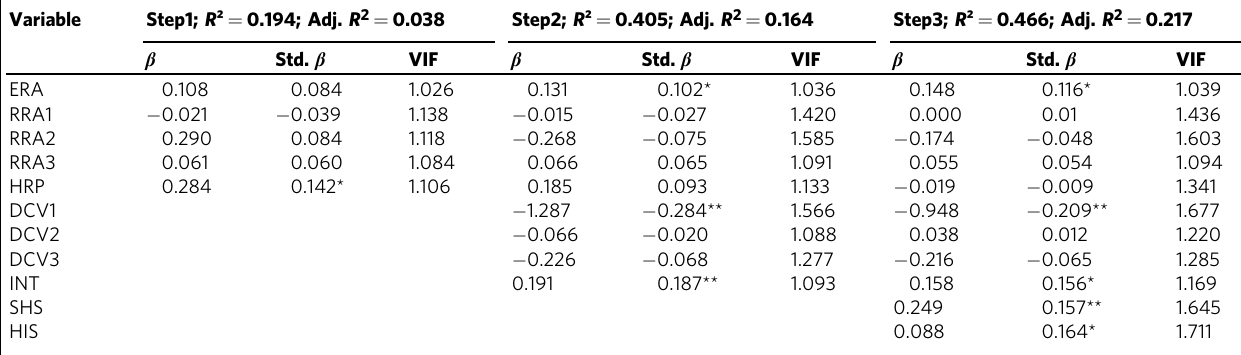
Table 11 Hierarchical regression analysis of heat adaptation behaviour. Variable